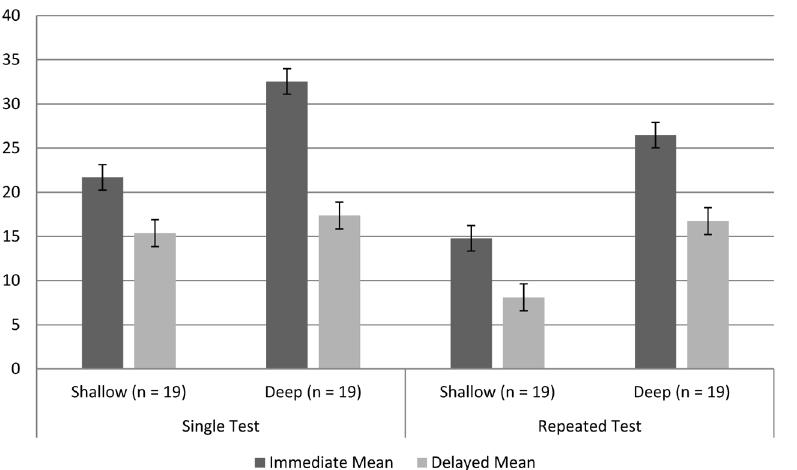
Figure 1. Means and standard error of the number of words (Total = 40) recalled in immediate and delayed final recall by test trial and processing level (N =